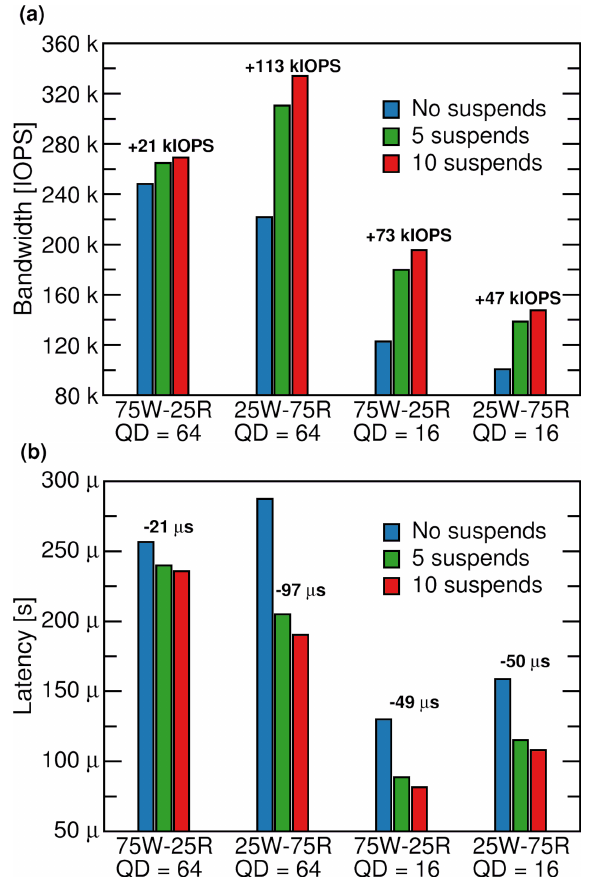
Figure 10. ( a ) The SSD bandwidth sustained. ( b ) The average total latency of the drive. Both metrics are given as a function of the workload and